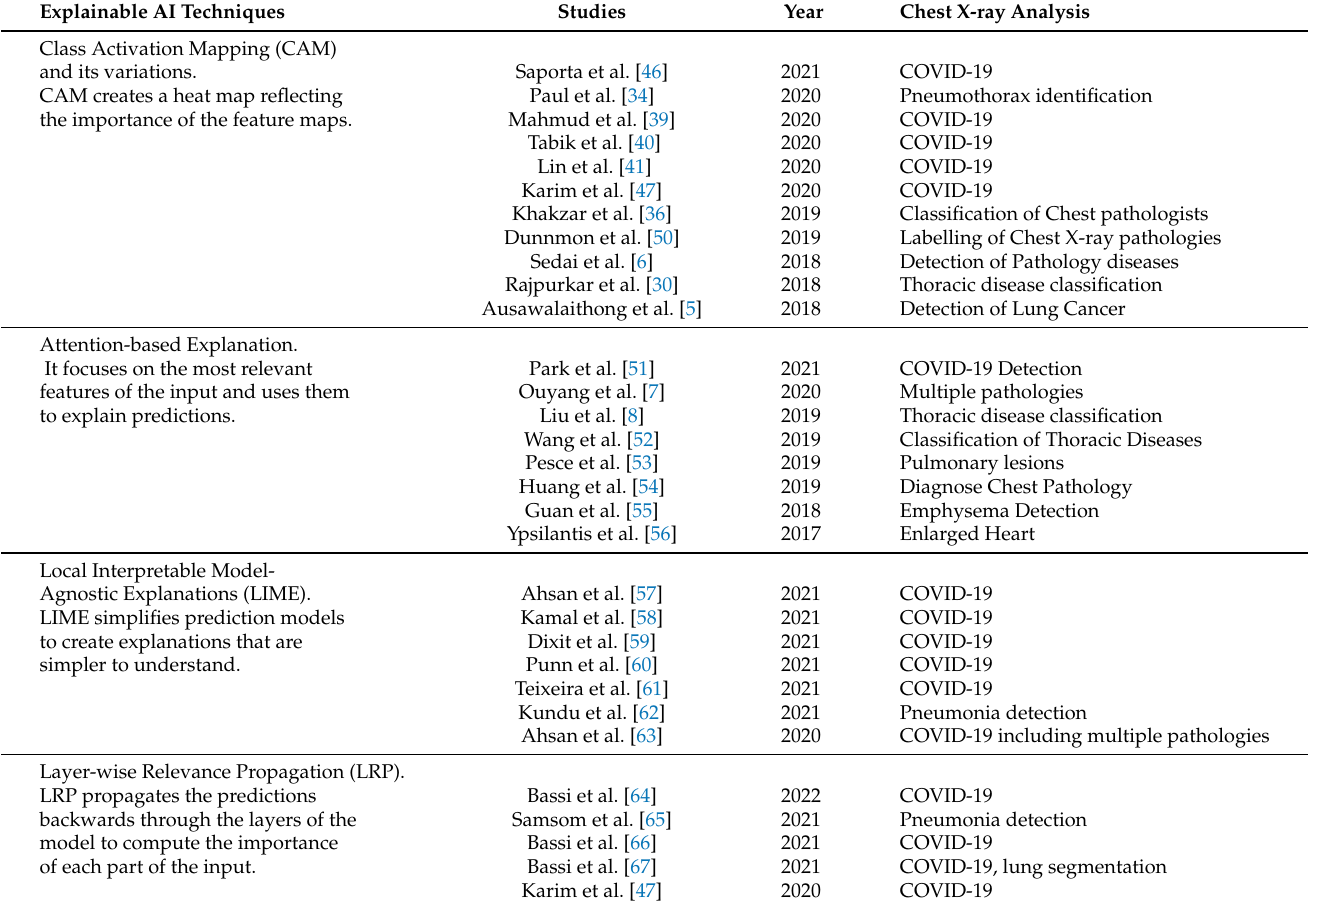
Table 1. Overview of explainable AI methods for chest X-ray image analysis. The last column explains the disease or anomaly predicted by a model, and the first column indicates the XAI method used to explain the decisions of the